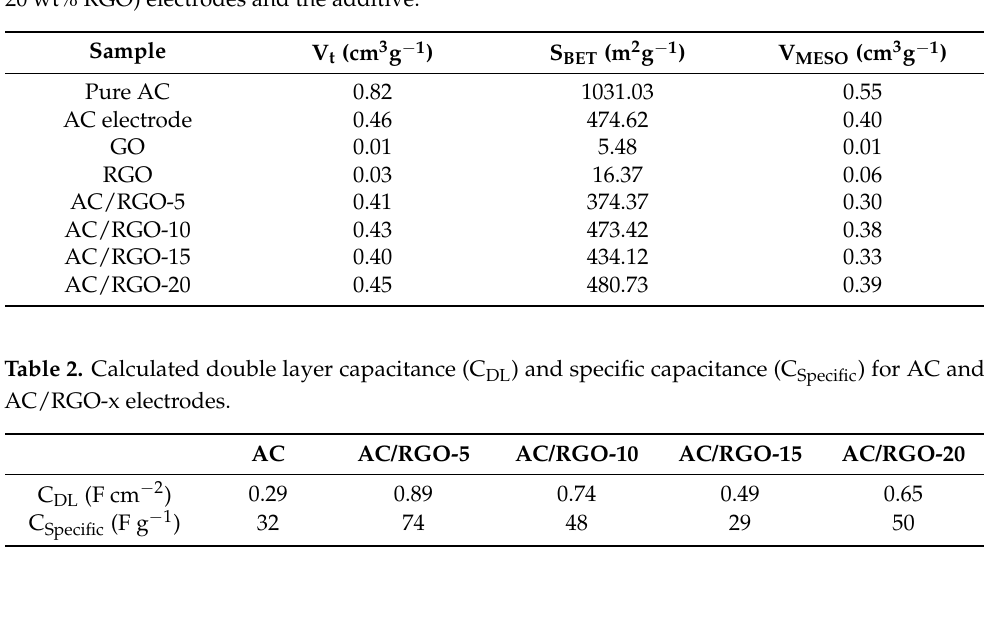
Figure 4. Isotherm linear plot of AC, and AC/RGO-x (where x = 5, 10, 15, and 20 wt% RGO). Table 1. Textural parameters of pure AC, AC electrode, and AC/RGO-x (where x = 5, 10, 15, and 20 wt% RGO) electrodes and the additive.